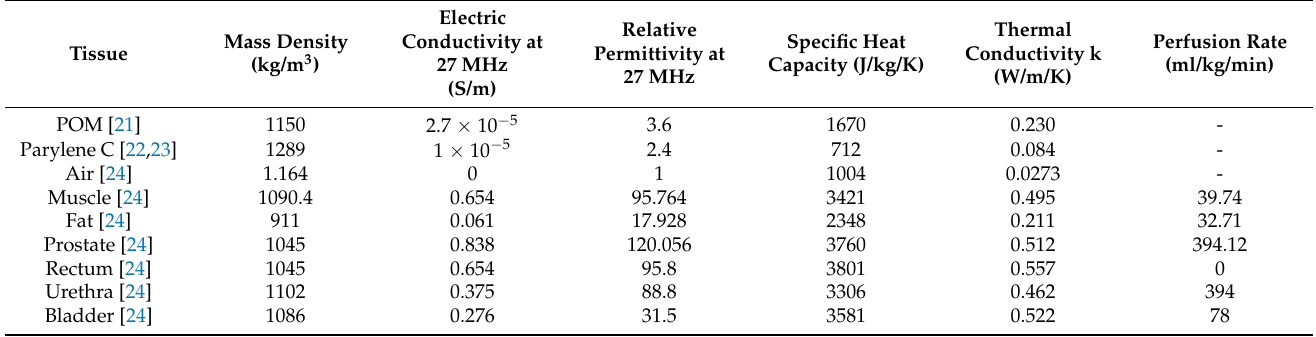
Table 1. Electric and Thermal properties of the applicator materials and the tissues used in the simulations.